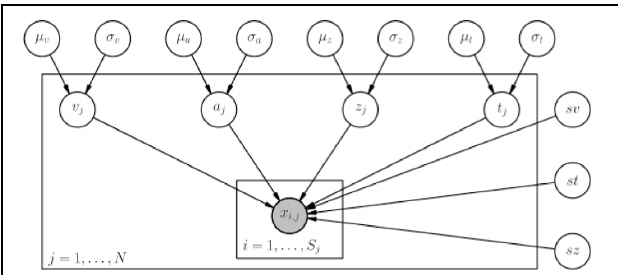
FIGURE 2 | Basic graphical hierarchical model implemented by HDDM for estimation of the drift-diffusion model. Round nodes represent random variables. Shaded nodes represent observed data. Directed arrows from parents to children visualize that parameters of the child random variable are distributed according to its parents. Plates denote that multiple random variables with the same parents and children exist. The outer plate is over subjects while the inner plate is over